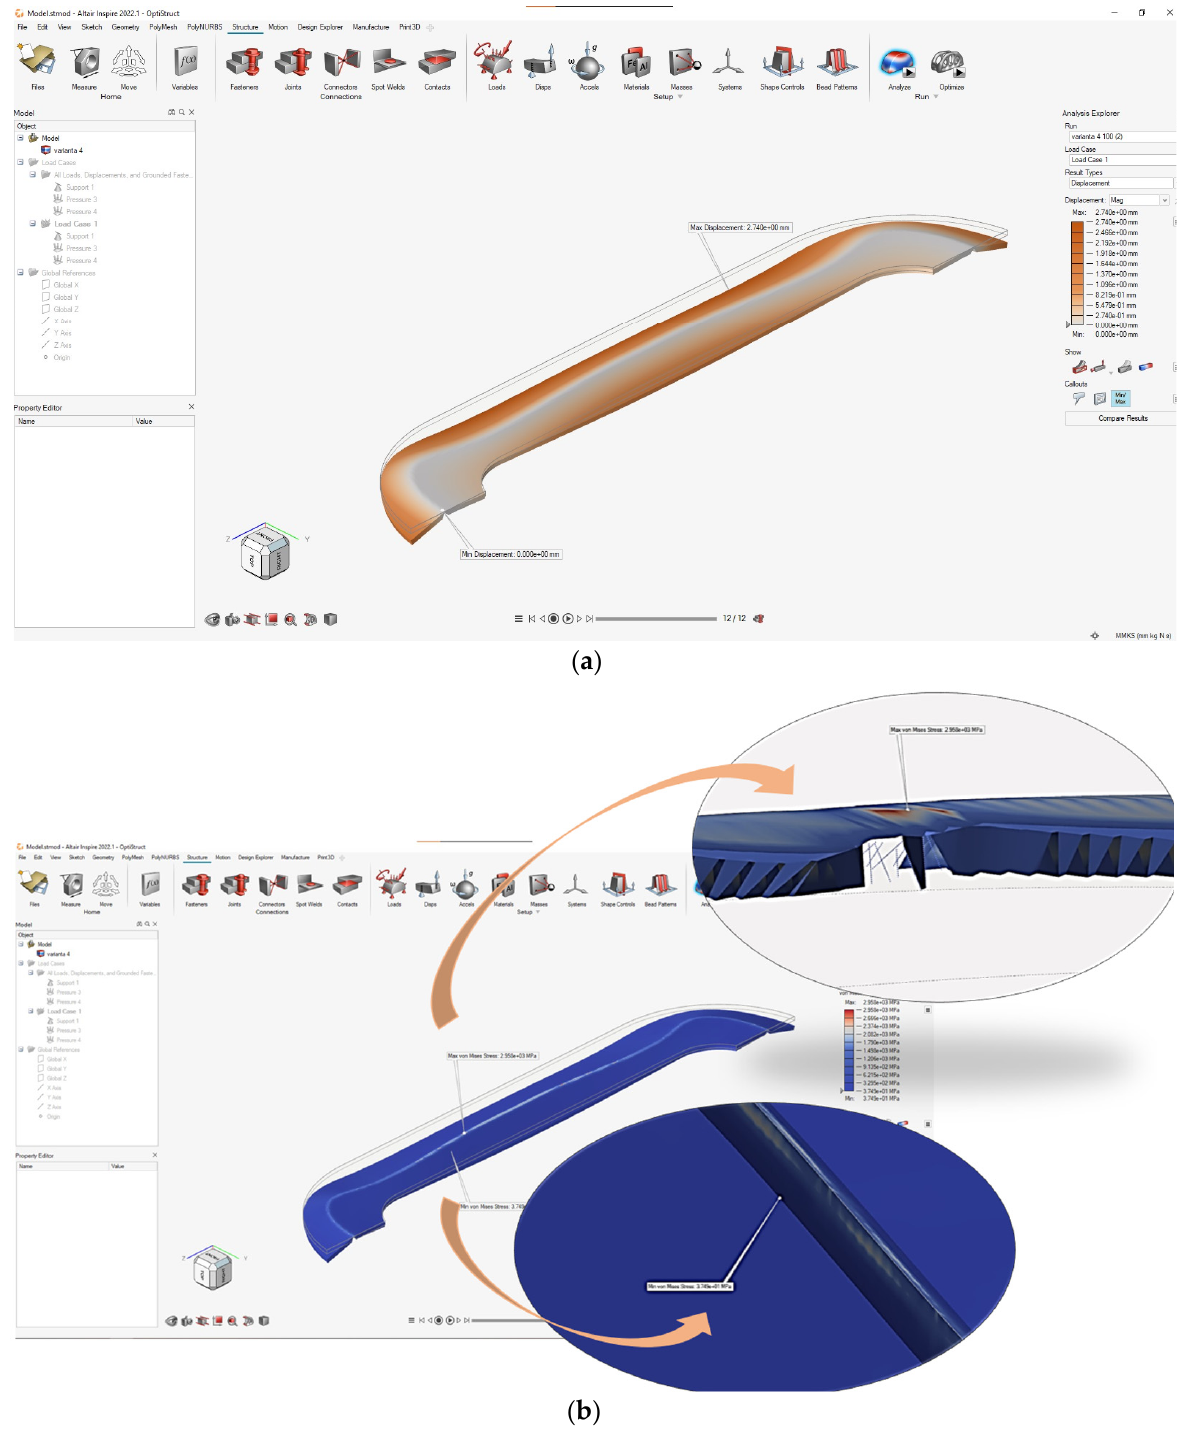
Figure 32. The model no. 3: ( a ) deformations; ( b ) von Mises equivalent stresses.